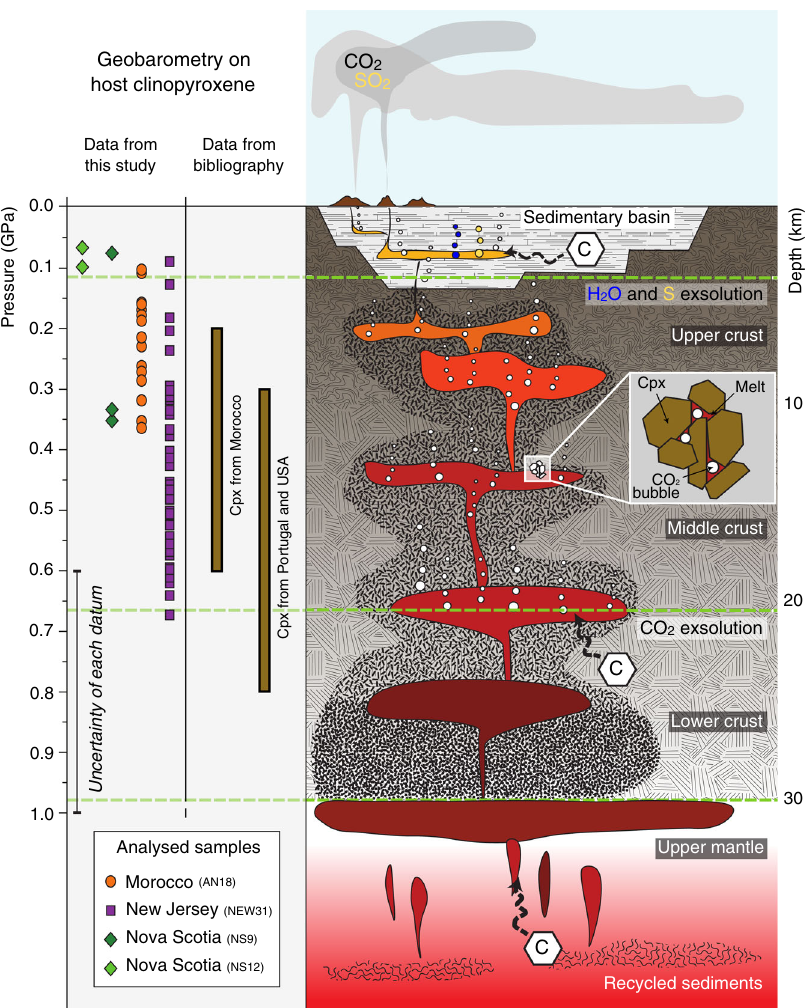
Fig. 7 Sketch of the transcrustal plumbing system of CAMP basaltic magmas from the mantle to the surface. The evolution of basaltic magmas occurs at variable depth by crystallization of minerals, which then form aggregates in crystalline mushes 13,14 and entrain bubble-bearing melt, forming MIs. Different volatile species exsolve at variable depth 16 . In particular, CO 2 -rich fl uids (white bubbles) start exsolving at great depth, whilst H 2 O-rich fl uids (blue bubbles) and S-rich fl uids (yellow bubbles) start exsolving at shallow depth. The black dashed arrows indicate the potential sources for the carbon in CAMP magma: the mantle, the deep crust and the Palaeozoic or Triassic sedimentary basins in which CAMP sills intruded. The carbon within the here studied MIs derives from the deep sources as demonstrated with clinopyroxene geobarometry data. Clinopyroxene crystallization pressures of this study have been calculated using ref. 37 (Supplementary Note 2). Clinopyroxene crystallization pressures of bibliography are from ref. 23 for Morocco, ref. 39 for Portugal, and ref. 40 for USA. The error (±0.2 GPa) takes into account the uncertainties from both the geobarometry model (±0.1 GPa) 37 and the electron microprobe analyses (±0.1 GPa, deriving from the ±10% accuracy on measured Na